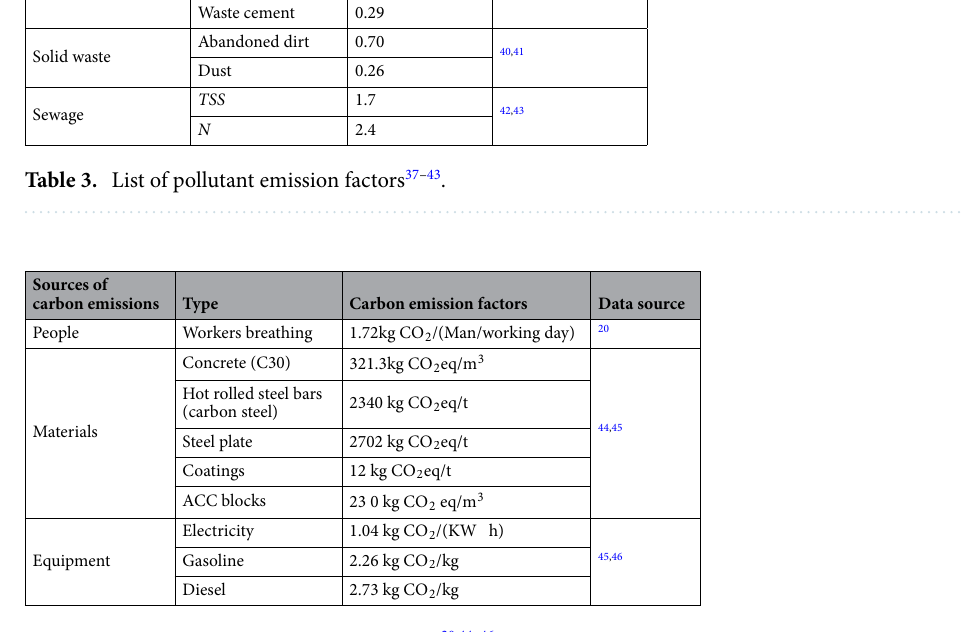
Table 4. Inventory of carbon emission factors 20,44–46